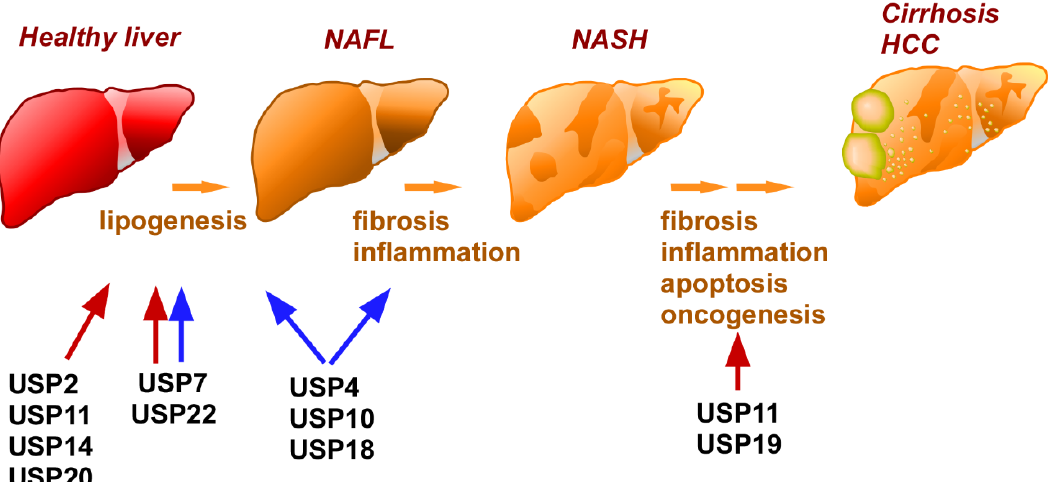
Figure 2. Roles of USPs in non-alcoholic fatty liver disease (NAFLD). NAFL, NASH, and HCC stand for non-alcoholic fatty liver, non-alcoholic steatohepatitis, and hepatocellular carcinoma, respectively. Blue and red arrows represent the restorative and deteriorative effects, respectively, of various USPs on